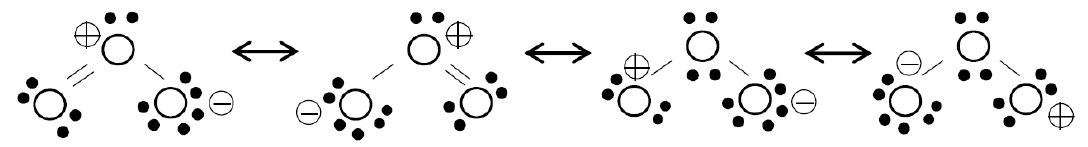
Figure 1. Electronic forms of an ozone molecule.